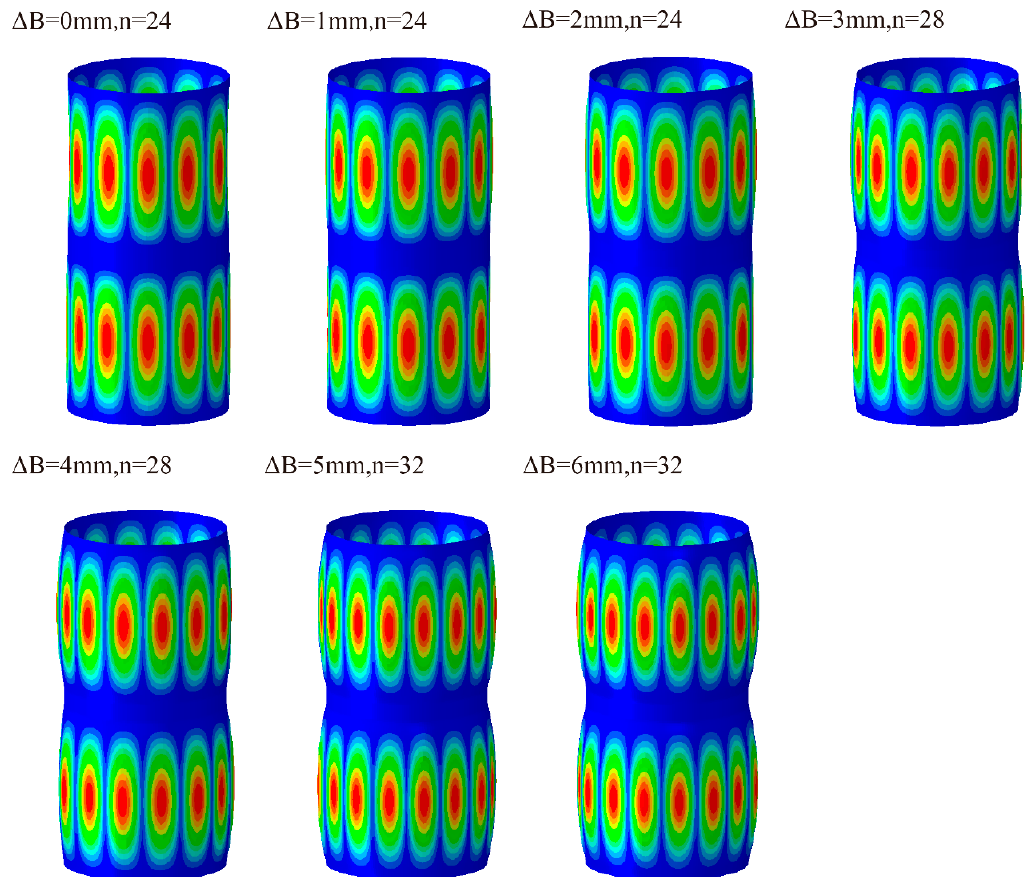
Figure 20. Linear buckling modes of bi-segment bulged hulls as obtained from numerical analysis.